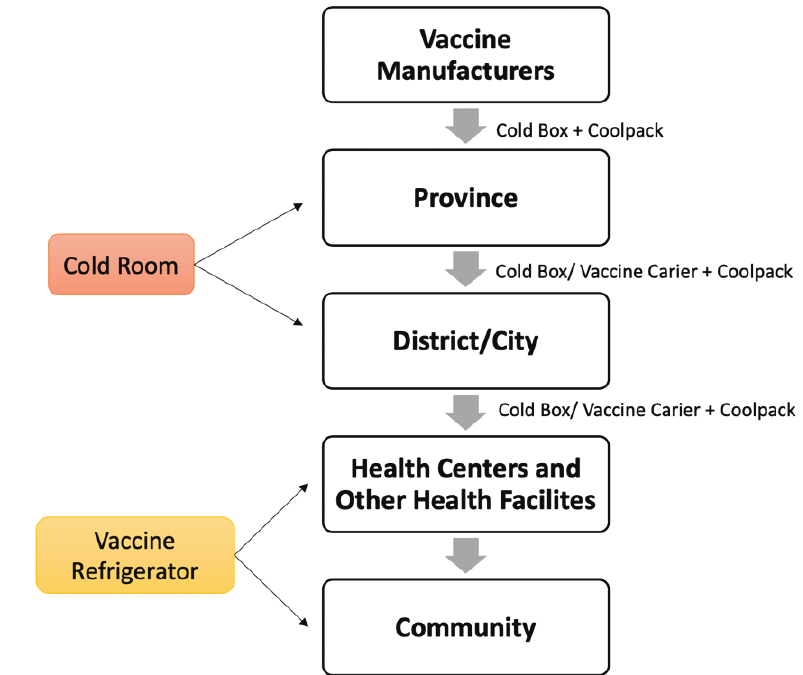
Figure 2. Vaccine Distribution Flowchart in Indonesia (Ministry of Health of Indonesia 2021a).